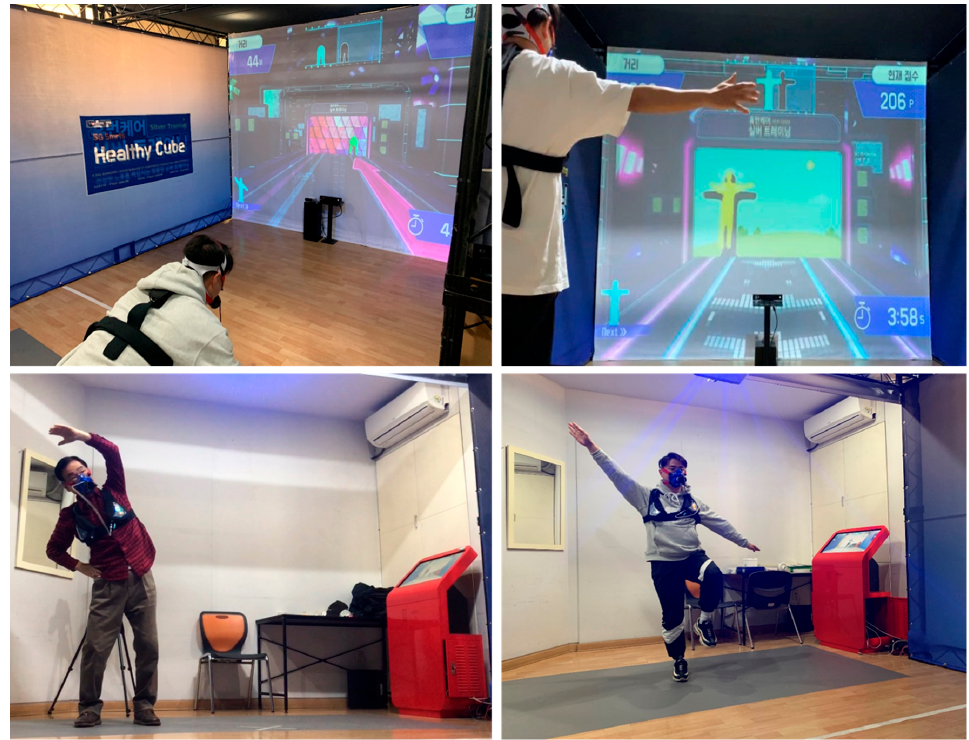
Figure 1. Exergames (Action-Racing).